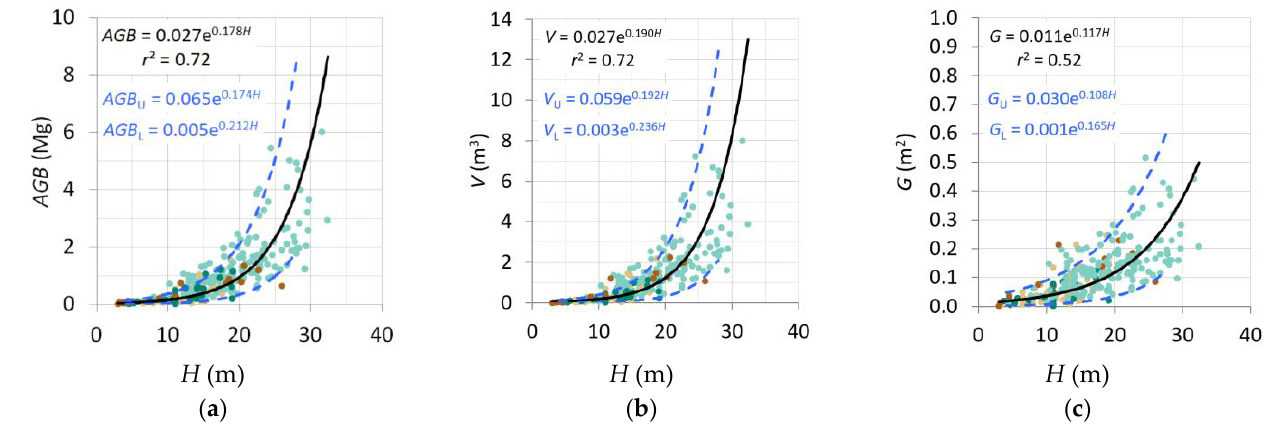
Figure 12. Relationships between forest structural variables versus in situ tree heights (dominant, codominant, and intermediate). Light green dots refer to downy oak, dark green dots refer to holm oak, yellow dots refer to field maple, brown dots include sweet chestnut plus secondary species. The exponential trend line (continuous black line) refers to all the species, while lower and upper dashed lines refer to the 5th and 95th percentile curves, respectively. The regression equations are also reported: AGB for the trend line (in black), and AGB L and AGB U for the 5th and 95th percentiles, respectively (in blue). Forest structural variables include ( a ) AGB , ( b ) V , and ( c ) G .